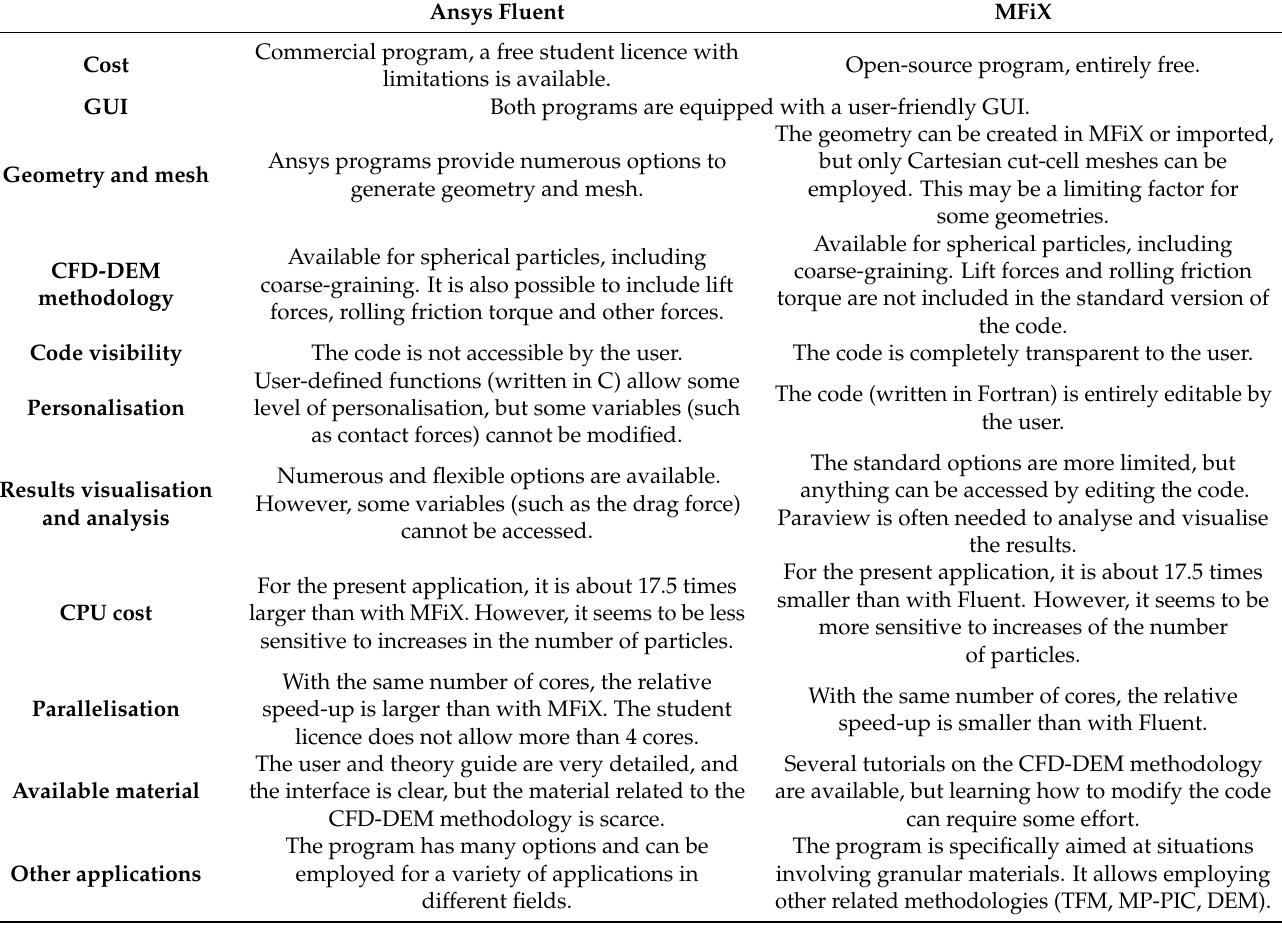
Table 3. Point-by-point comparison of Ansys Fluent and MFiX applied to CFD-DEM. Ansys